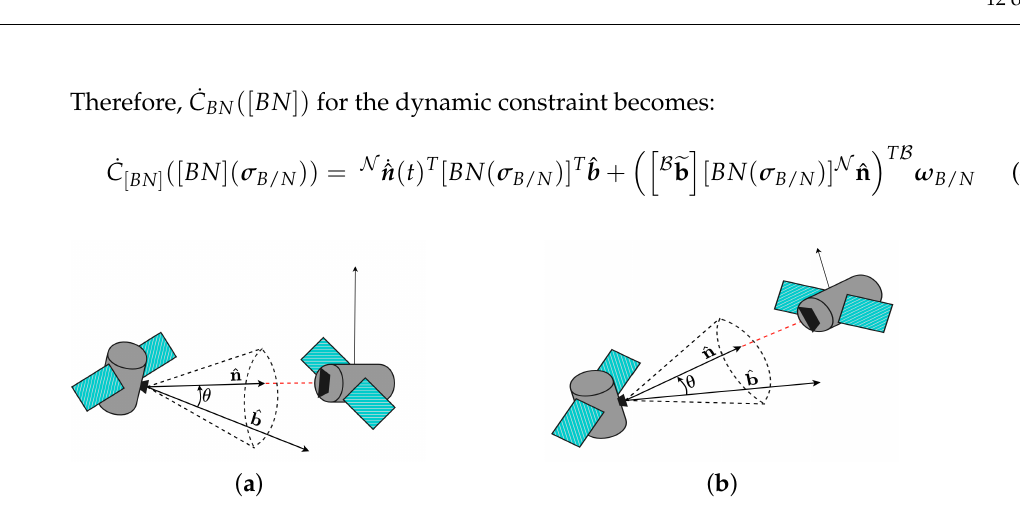
Figure 8. Dynamic Inclusion Constraint Geometry. A laser device is attached to a satellite on the left and must be pointed at another satellite’s receiver on the right. ( a ) is the initial position of the satellites and ( b ) is an arbitrary position after some specified